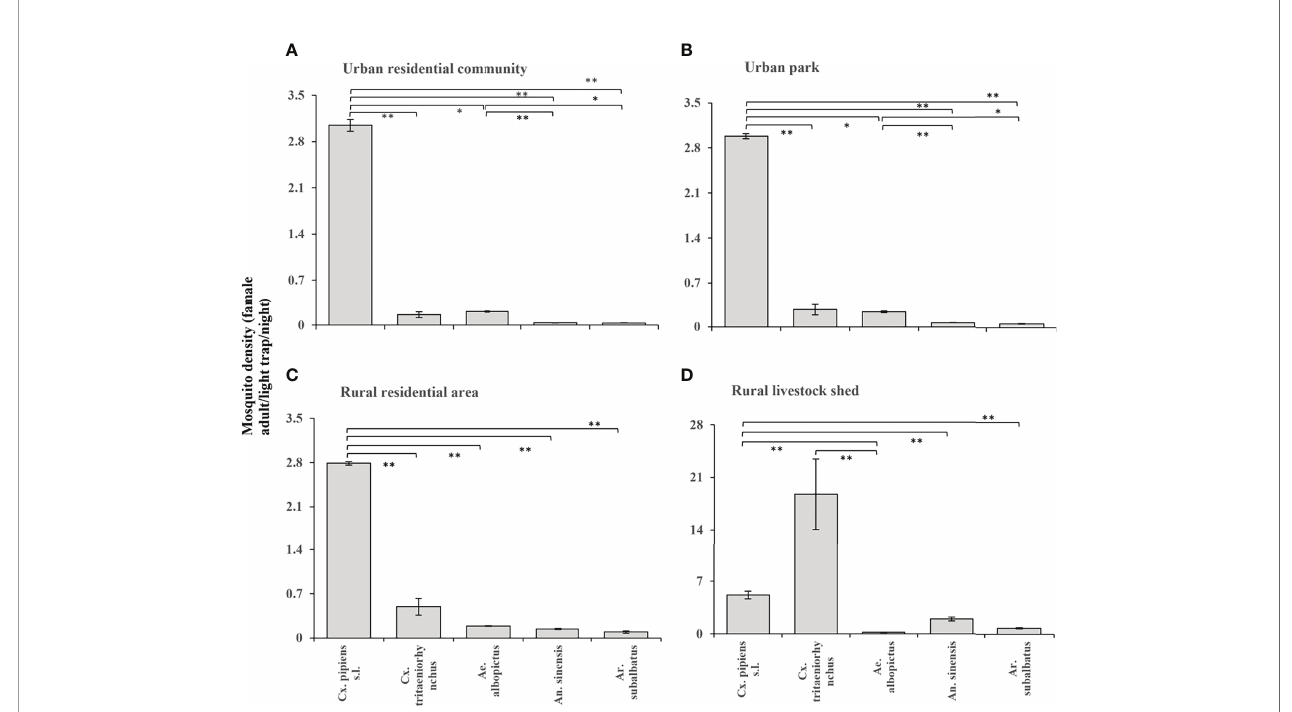
FIGURE 3 | According to the entomological investigation from 2018 to 2020, the density of female mosquitoes of different species in different habitats. (A) Urban residential community; (B) Urban park; (C) Rural residential area; (D) Rural livestock shed. Values are the mean + standard error. Different patterns indicate signi fi cantly different (*: p<0.05; **: p<0.01).